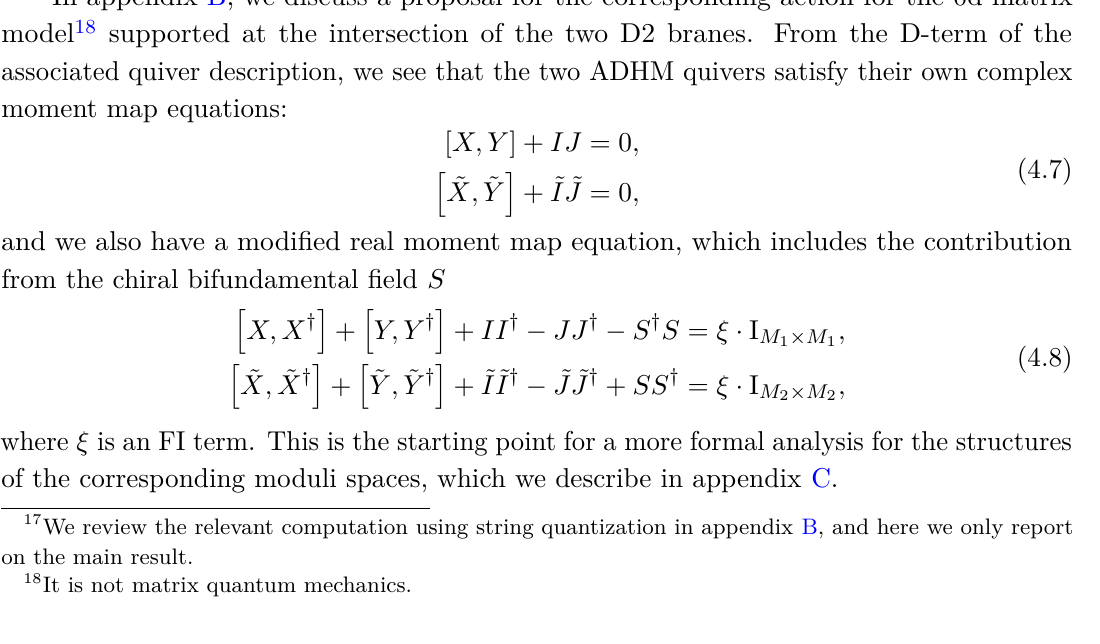
0 0 N ⊗ B 12 =1 A K A